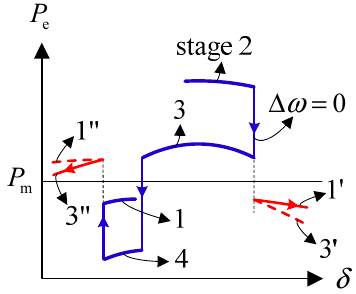
Figure 3. Schematic diagram of the destruction of the stage sequence.